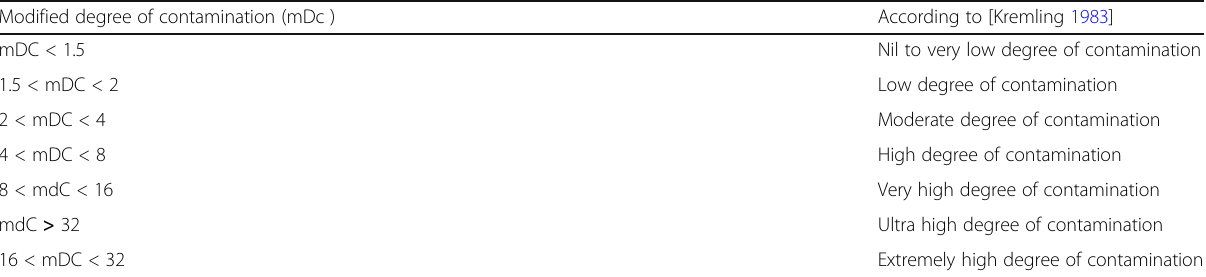
Table 3 Grading of modified degree of contaminations Modified degree of contamination (mDc